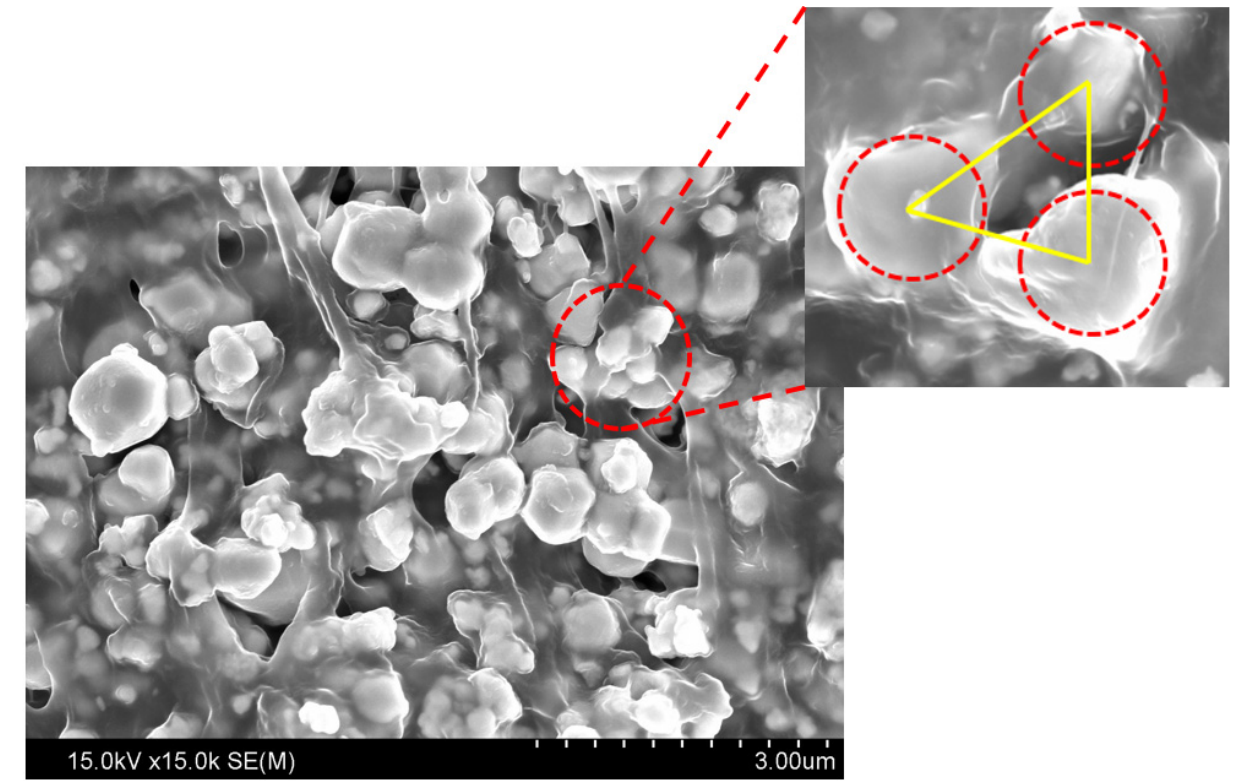
Figure 7. Degree of dispersion of tungsten particles in the double-shell structure when using the powder polymer. The circles and triangles on the upper right represent regular intervals between particles.